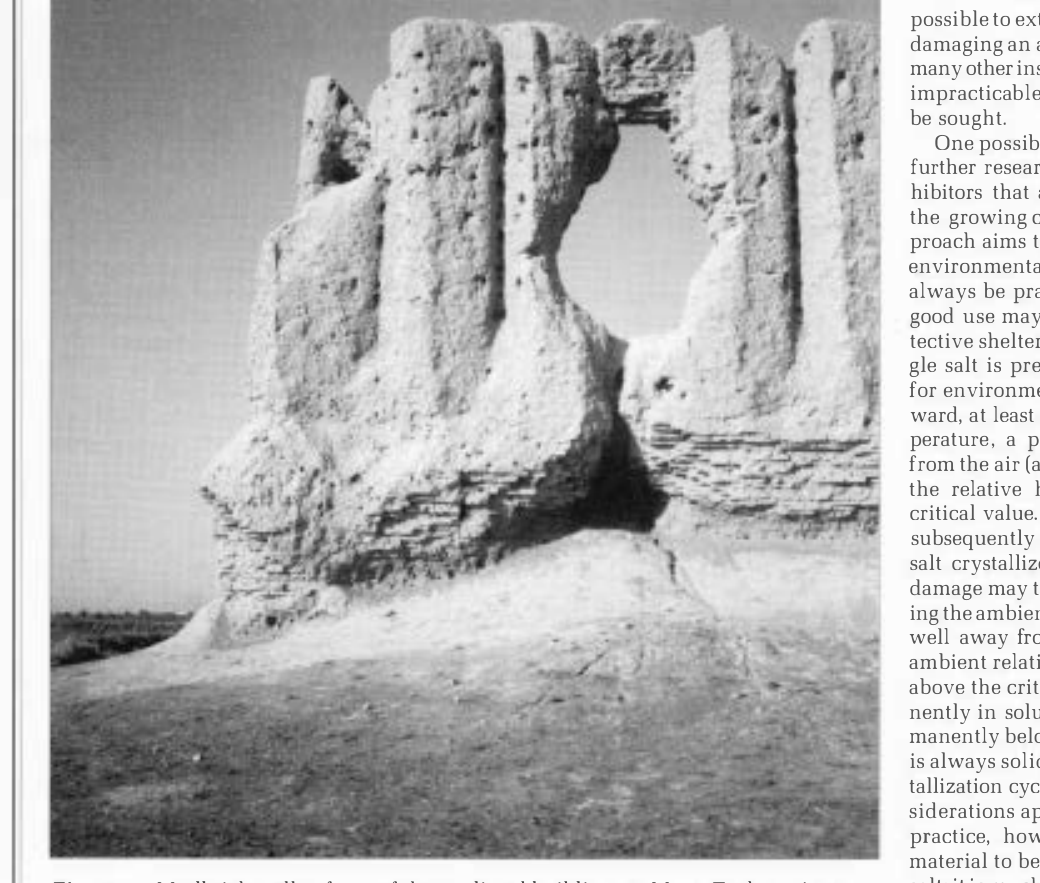
Figure 1 Mudbrick walls of one of the medieval buildings at Merv, Turkmenistan, undermined by salt damage.